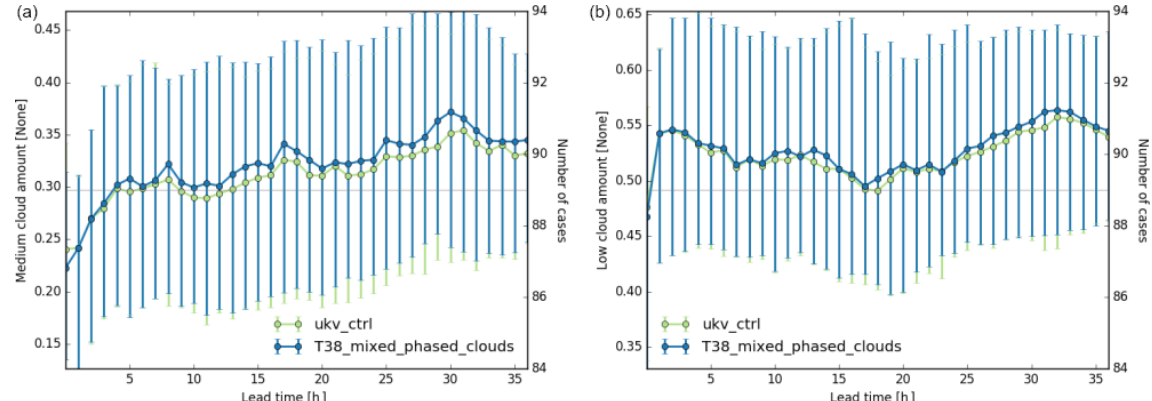
Figure 8. Medium cloud (a) and low cloud (b) amounts in UKV case studies run with improved ice cloud fraction in mixed phase